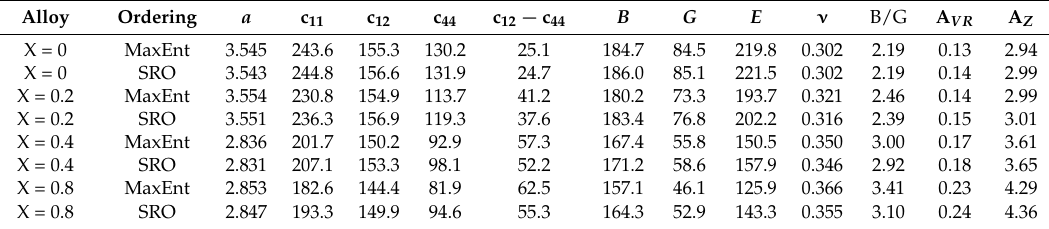
Table 7. Calculated lattice parameters a (Å), elastic constants (c 11 and c 44 ), bulk modulus B , shear the elastic moduli is